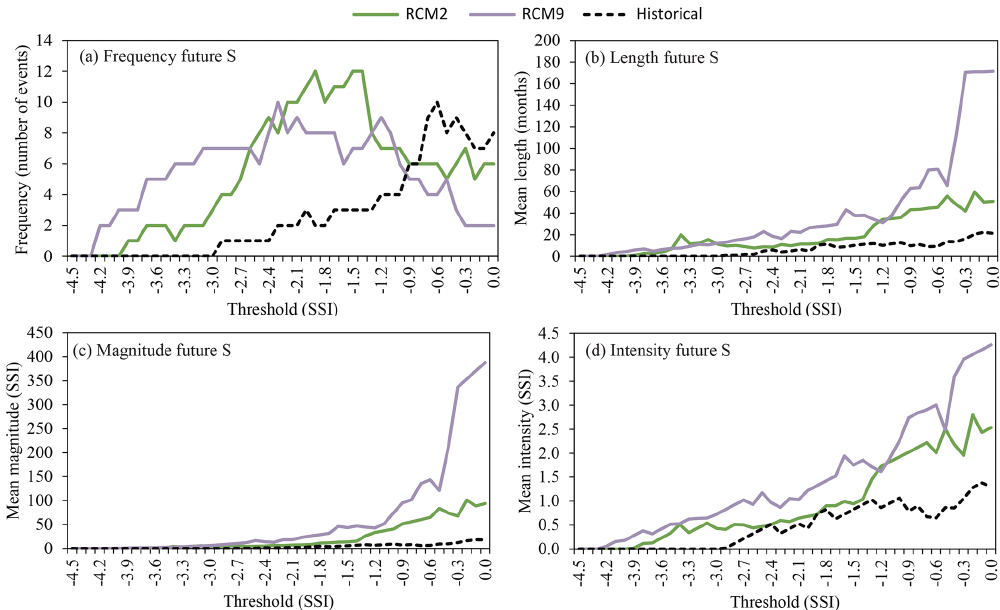
Figure 13. Drought statistics – (a) frequency, (b) length, (c) magnitude, (d) intensity – of the historical period (1972–2002) and future horizon (2071–2100) series (RCM2 and 9) for streamflow (hydrological